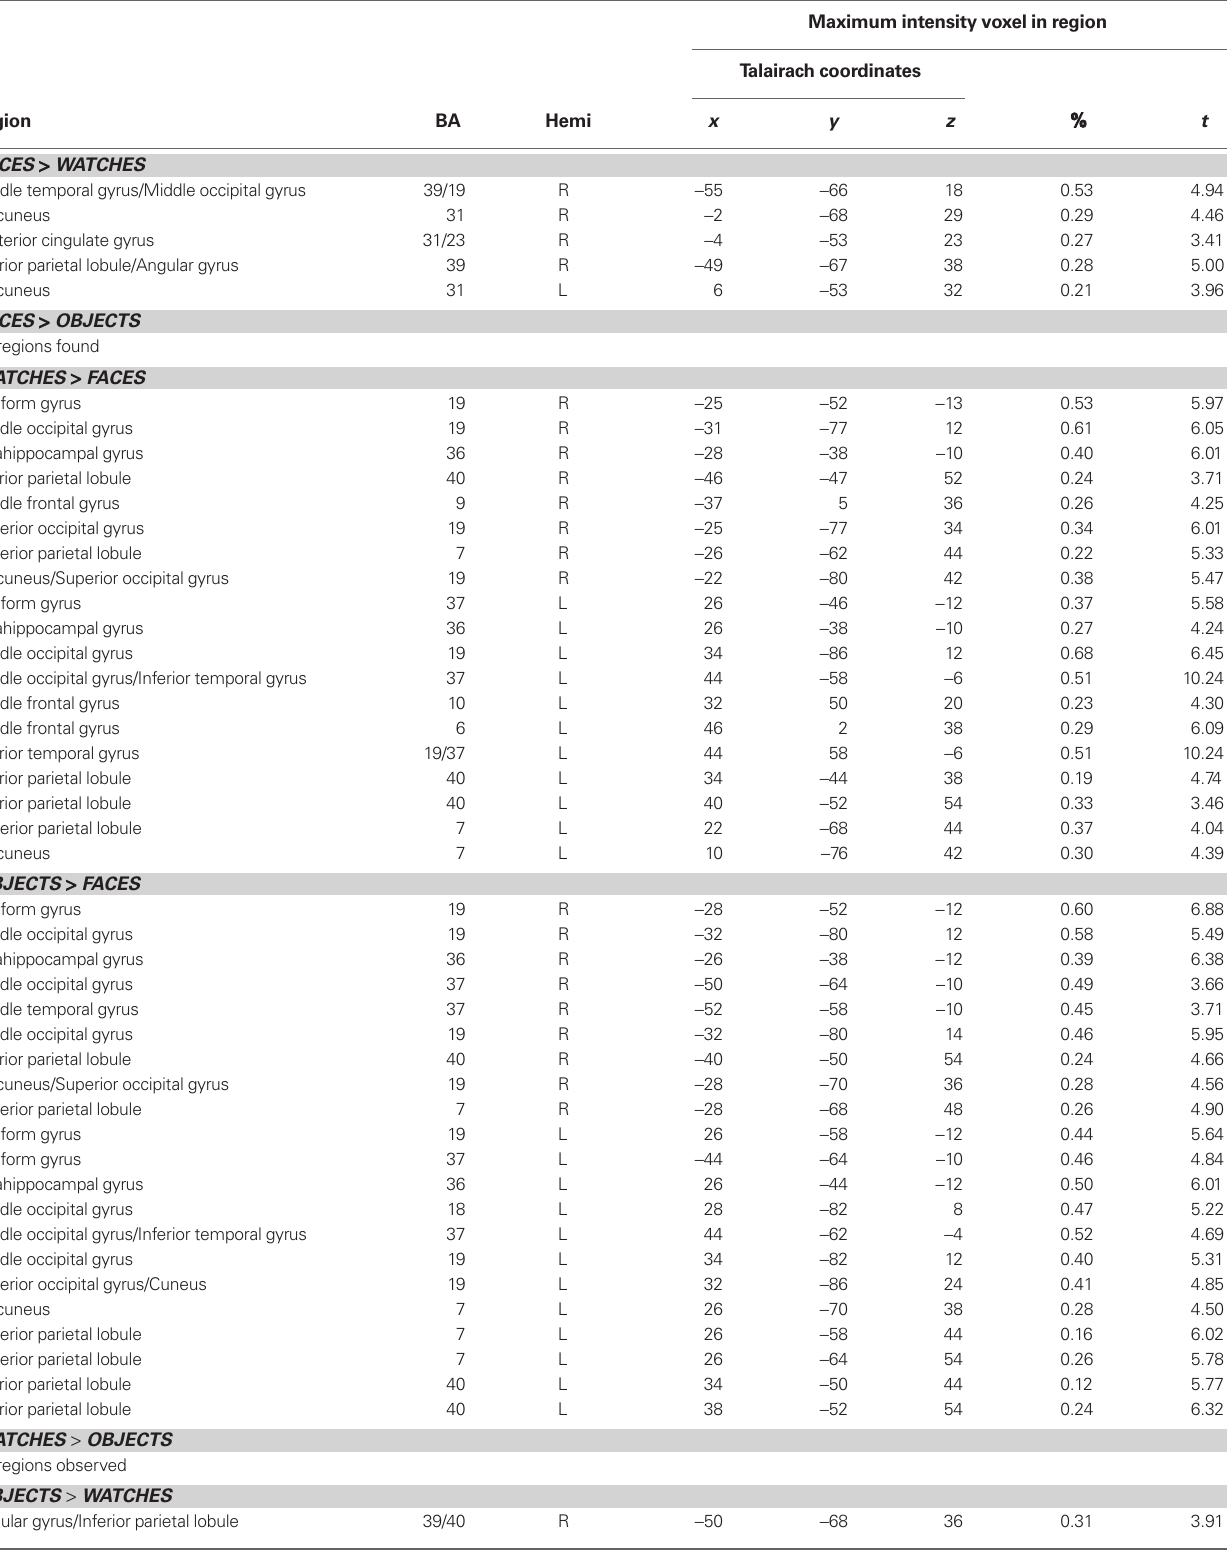
Maximum intensity voxel in region Talairach coordinates